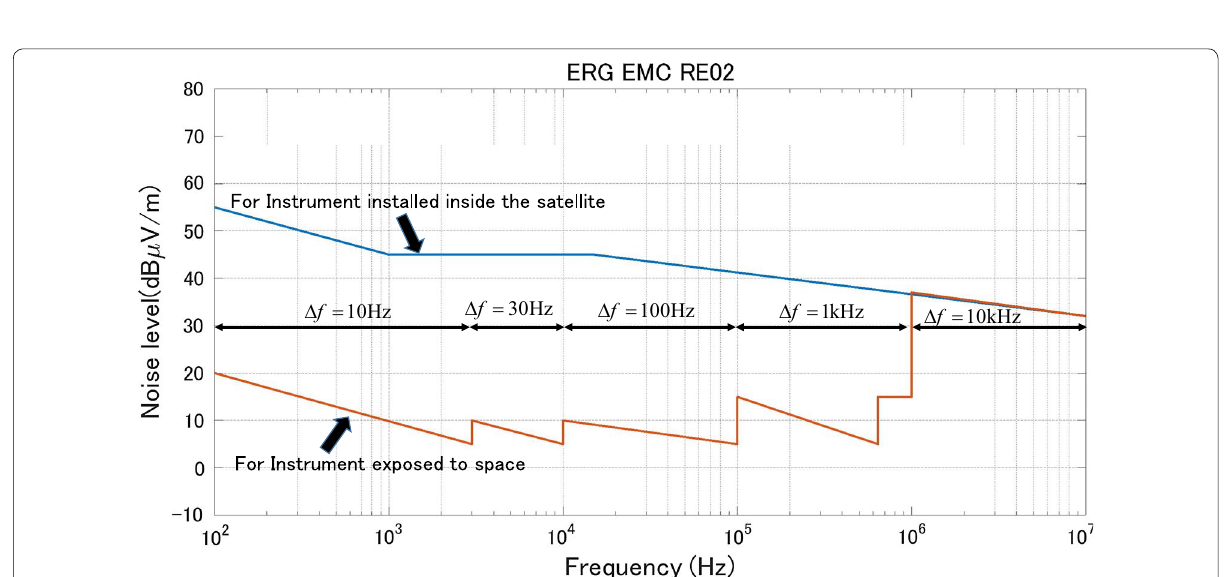
Fig. 16 Limit level for the electromagnetic compatibility (EMC) requirements of the radiated electric field noise